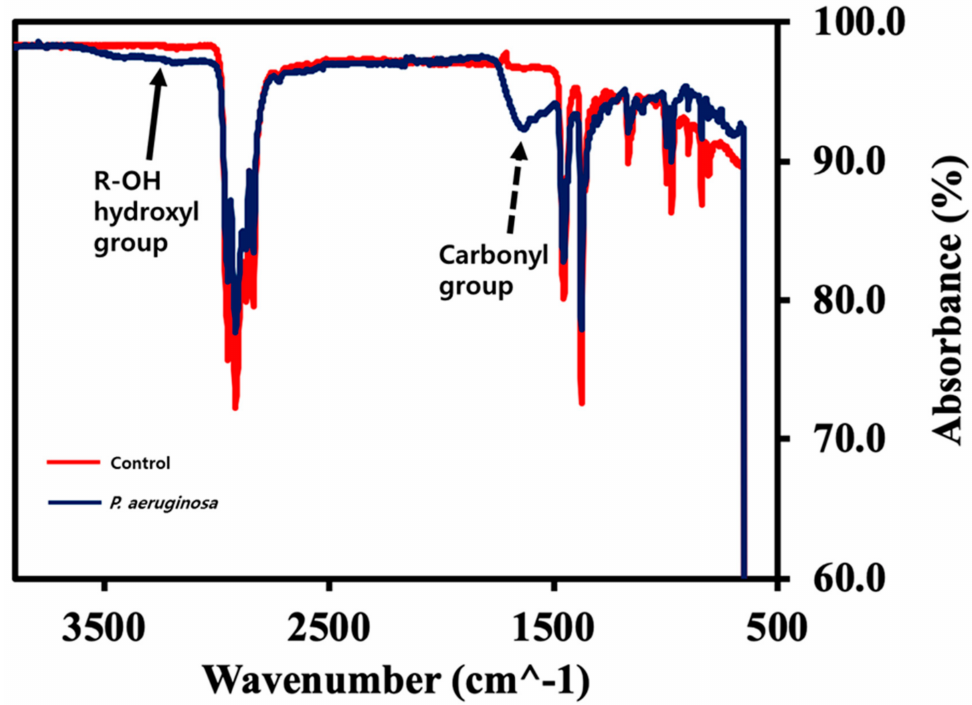
Figure 5. FT-IR analysis of chemical structural changes during PP biodegradation. FT-IR spectra of PP beads biodegraded by P. aeruginosa (blue line) versus control PP beads (red line). Solid line arrow, hydroxyl group (-O-H); Dotted line arrow, carbonyl group (-C =